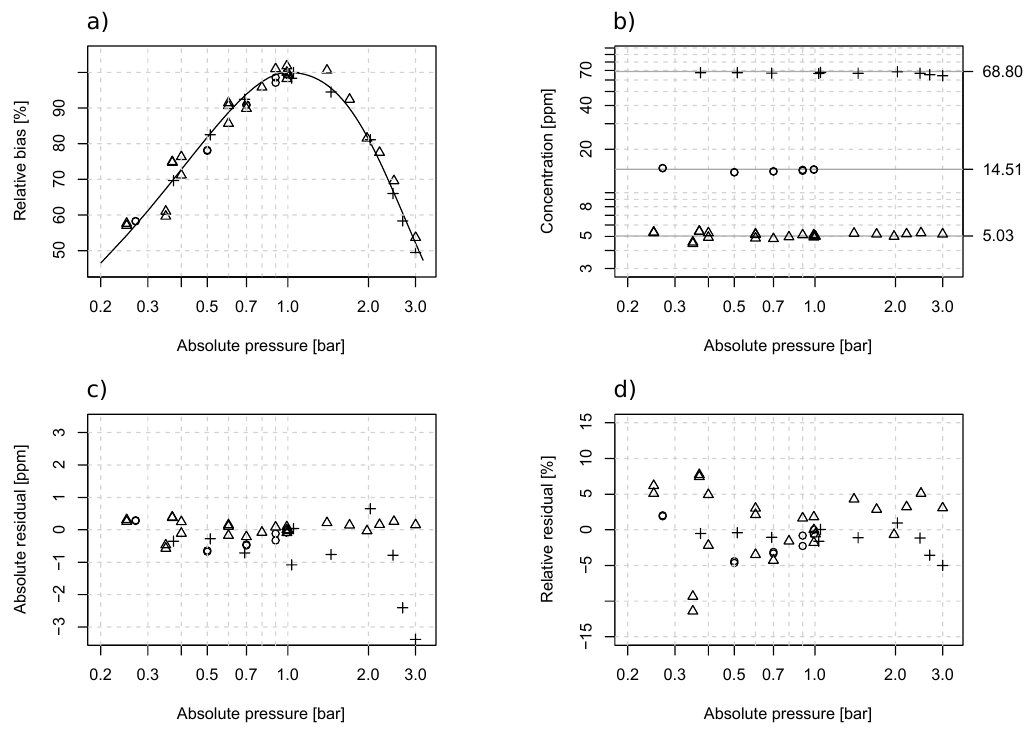
Figure 4. Pressure effect on the measurement bias of LGD F200 and correction results. The figures are respectively ( a ) the relative bias due to pressure and a fitted curve for compensation, ( b ) the concentration value after pressure compensation, ( c ) the absolute compensation residuals, and ( d ) the relative compensation residuals. Certified gas cylinders with 5.03 ± 0.15 ( (cid:13) ), 14.51 ± 0.4 ( (cid:52) ), and 68.8 ± 2.1 (+) ppm v NH 3 mixed in nitrogen were used in the